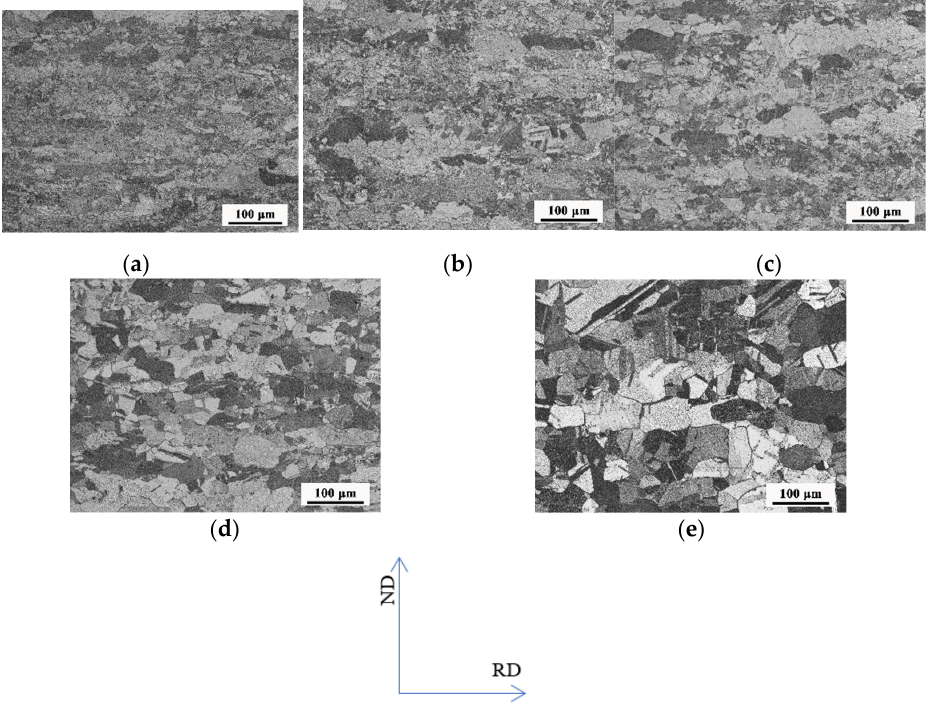
Figure 2. Optical micrograph of Ag with the longitudinal section: cold rolled ( a ) and following annealing at 300 ◦ C ( b ), 400 ◦ C ( c ), 500 ◦ C ( d ), 600 ◦ C ( e ), respectively (ND: Normal direction, RD: Rolling